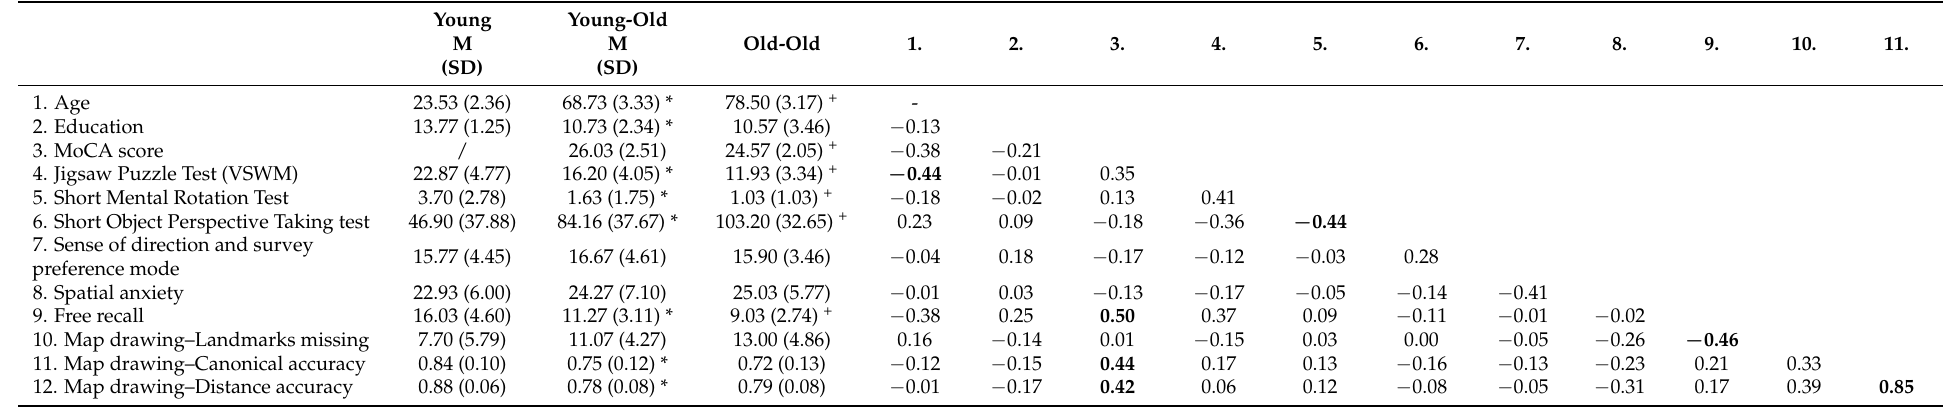
Table 1. Means and standard deviation of variables in the three group of age and correlations between variables in the two older